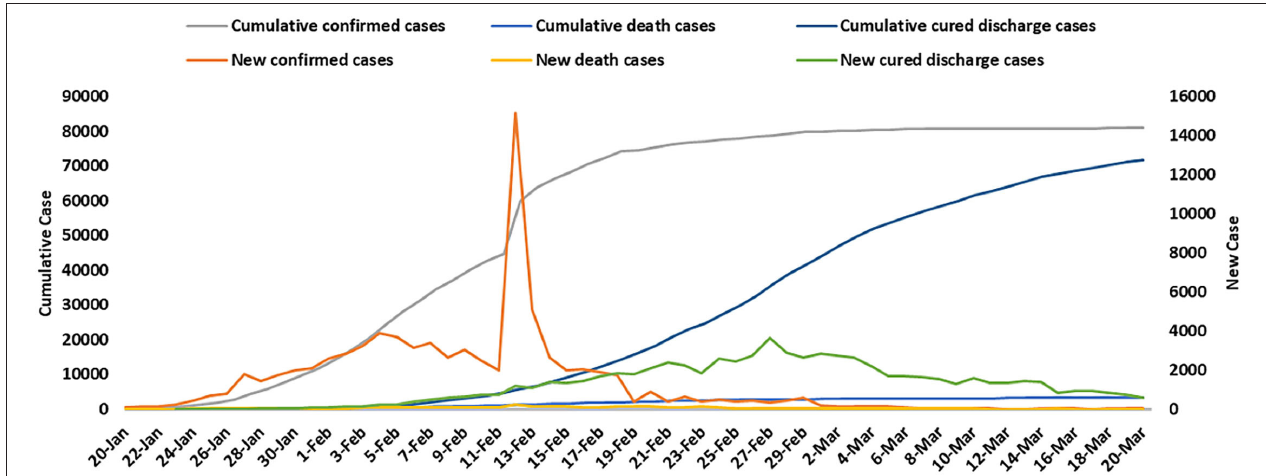
FIGURE 1 | The epidemic characteristics of COVID-19 in China from January 20 to March 20 in 2020.